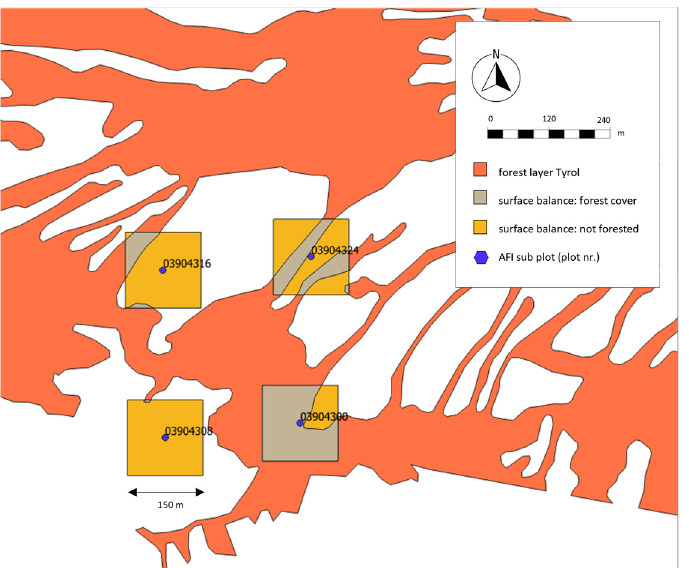
Figure 5. Assessment of surface balance (47°15 ′ 34.7724 ″ N, 11°24 ′ 1.3500 ″ E). Squares with side length 150 m are used to compute surface balance around AFI subplots (e.g., plot nr. 03904308) between forest (light orange polygons) and non-forest area (grey polygons) in QGIS.